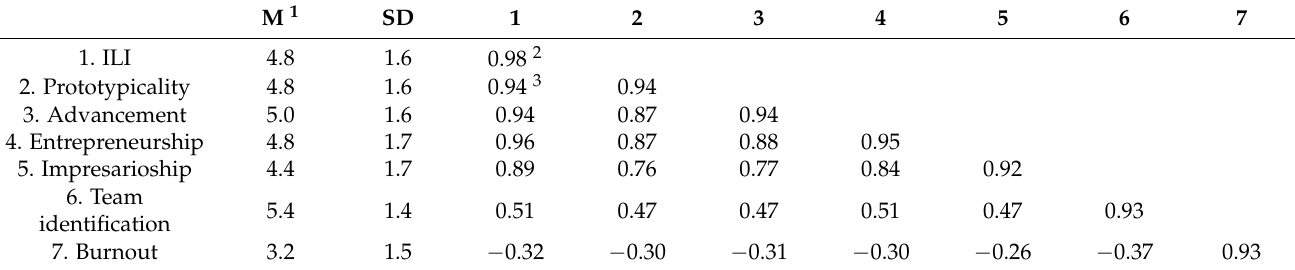
Table 2. Means, standard deviations and bivariate correlations between variables 2021.